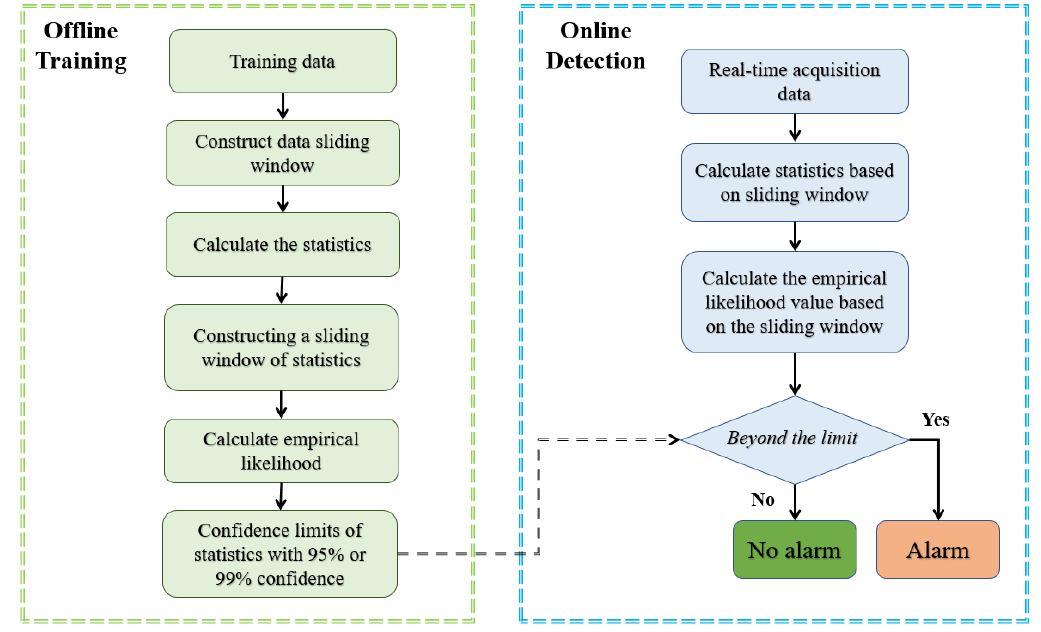
Figure 1. Flowchart of o ffl ine training and online